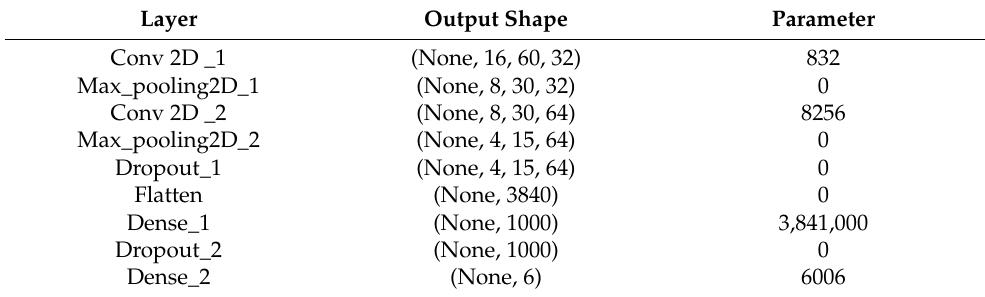
Table 9. Layers and numbers of parameters in the upper joint position input model.